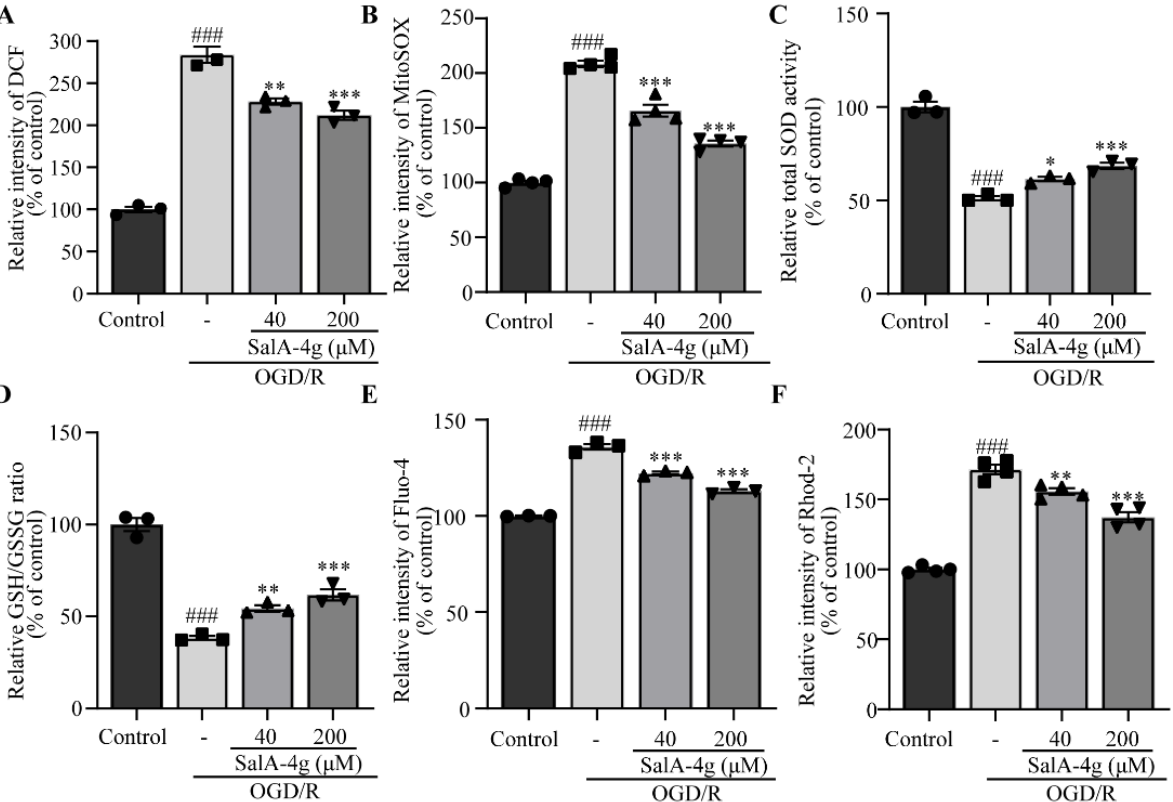
Figure 4. SalA-4g alleviates mitochondrial oxidative stress and calcium overload in cortical neurons under OGD/R stress. ( A ) The levels of intracellular ROS of control cells, cells exposed to 2.5 h of OGD and 24 h of reoxygenation alone, and cells treated with different concentrations of SalA-4g during OGD/R period. ( B ) The levels of mitochondrial superoxide in neurons after treatments, as mentioned above. ( C ) The total SOD activity in neurons after treatments, as mentioned above. ( D ) The ratio of reduced GSH to oxidized GSH (GSSG) in different groups. ( E ) Quantification of Fluo-4 fluorescence in- tensity in different groups. ( F ) Quantification of Rhod-2 fluorescence intensity in different groups. All values are presented as mean ± SEM ( n = 3 or 4); ### p < 0.001 versus control; * p < 0.05, ** p < 0.01, and *** p < 0.001 versus OGD/R alone.